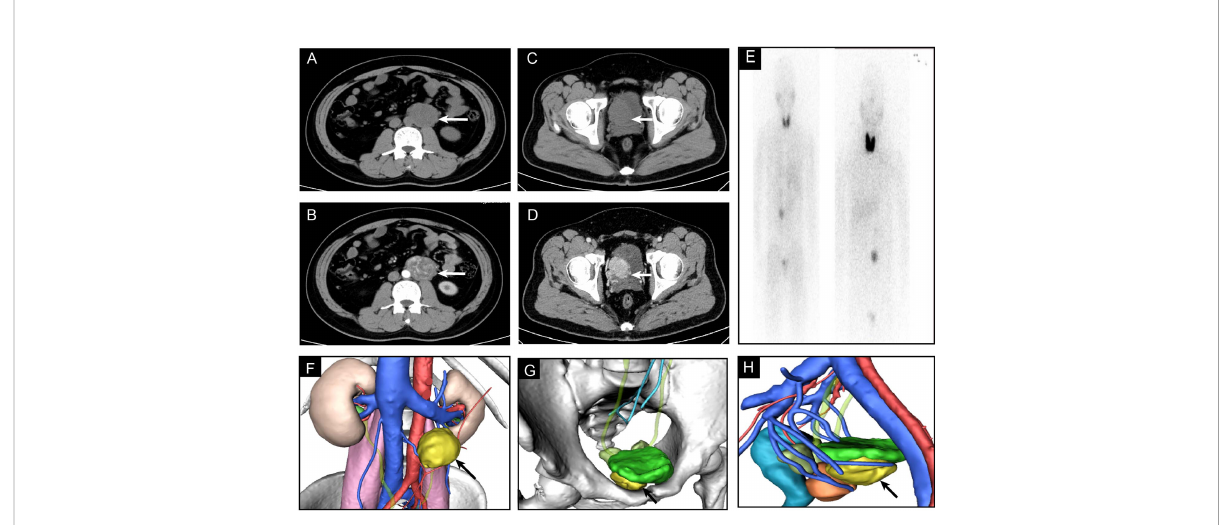
FIGURE 1 The enhanced CT and 3D model of PGLs. (A, B) Plain and enhanced CT images of PGL in abdomen. (C, D) Plain and enhanced CT images of PGL in pelvis. (E) MIBG scintigraphy. (F – H) 3D model of CT